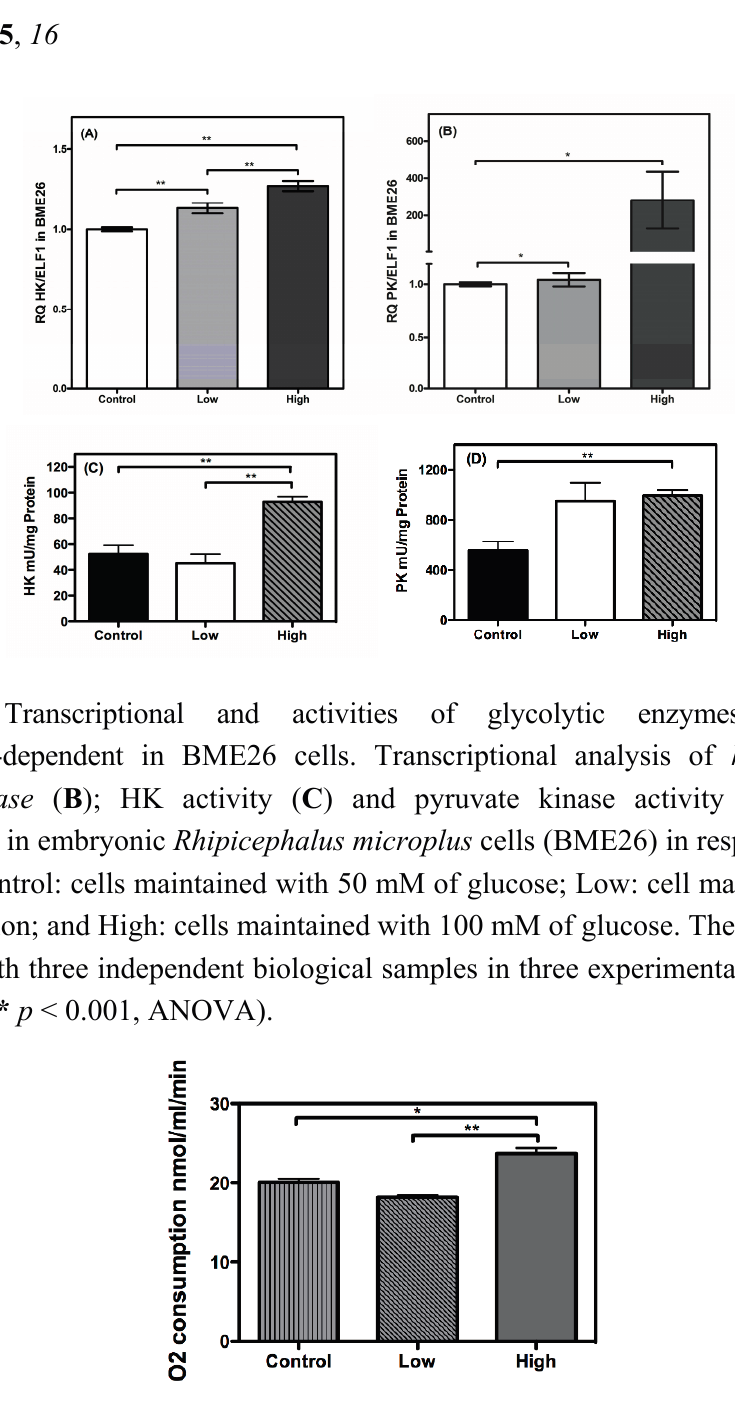
Figure 2. Higher oxygen consumption under high-glucose treatment. The oxygen consumption rate was measured in embryonic Rhipicephalus microplus cells (BME26) in response to glucose treatment. Control: cells maintained with 50 mM of glucose; Low: cell maintained without glucose addition; and High: cells maintained with 100 mM of